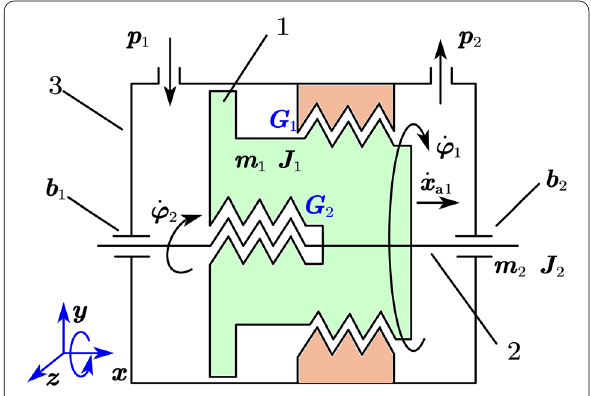
Figure 2 Schematic illustration of operating